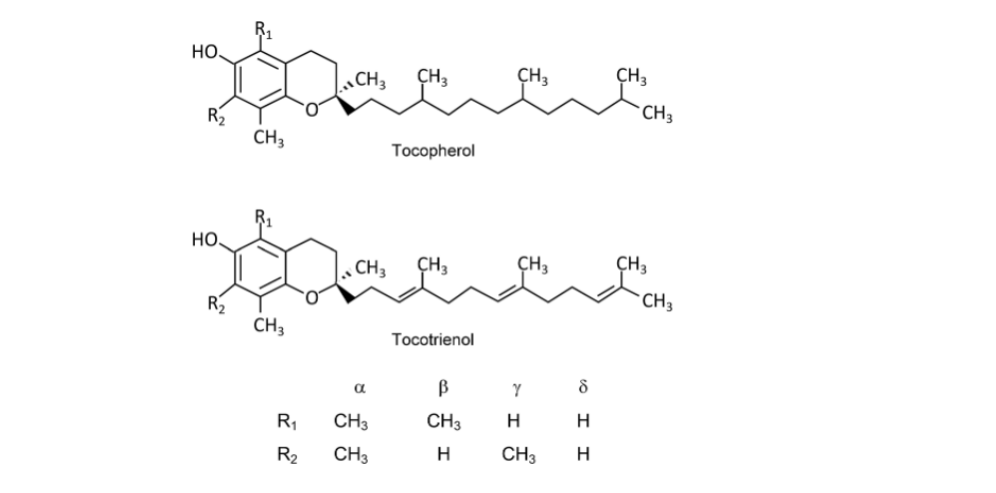
Figure 1. Structures of compounds belonging to the vitamin E group. Reprinted/adapted with permission from Ref. [5]. Copyright 2019, copyright Niki, E.; Abe, K